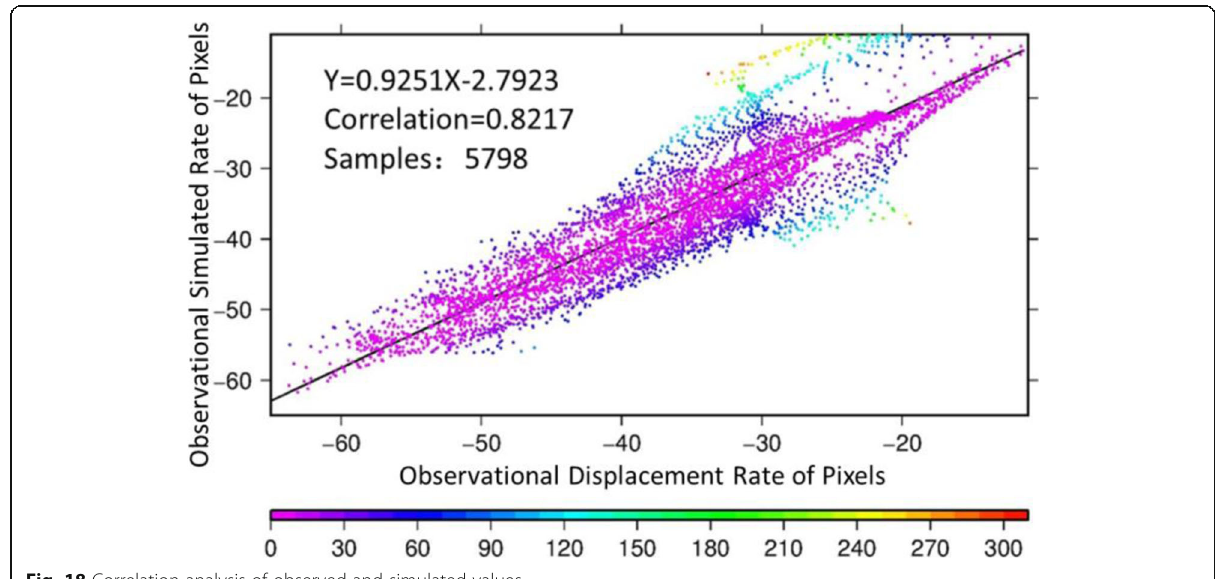
Fig. 18 Correlation analysis of observed and simulated values